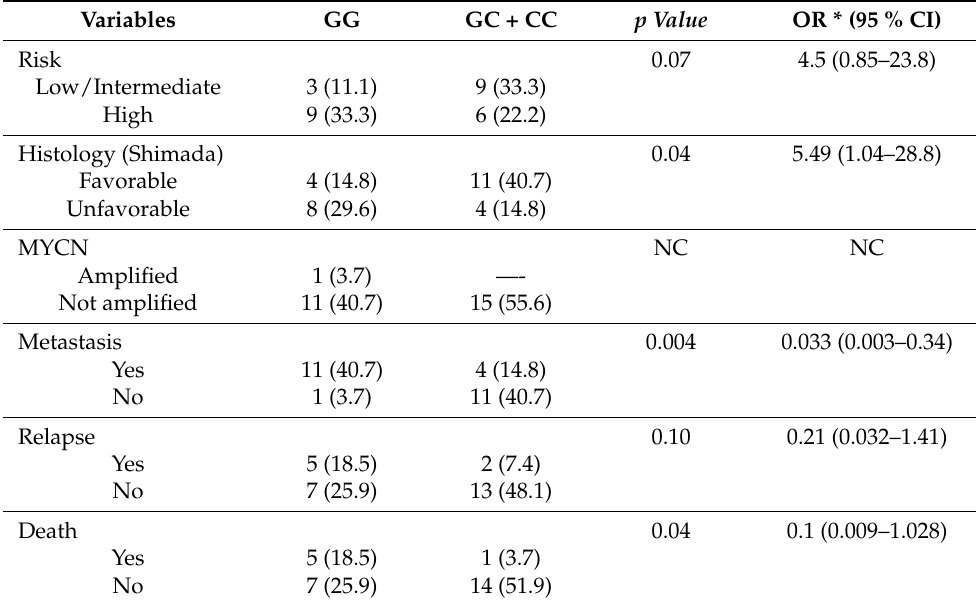
Table 6. Characteristics of NB patients stratified by genotype of the SNP IL-6 − 174 G > C rs1800795.